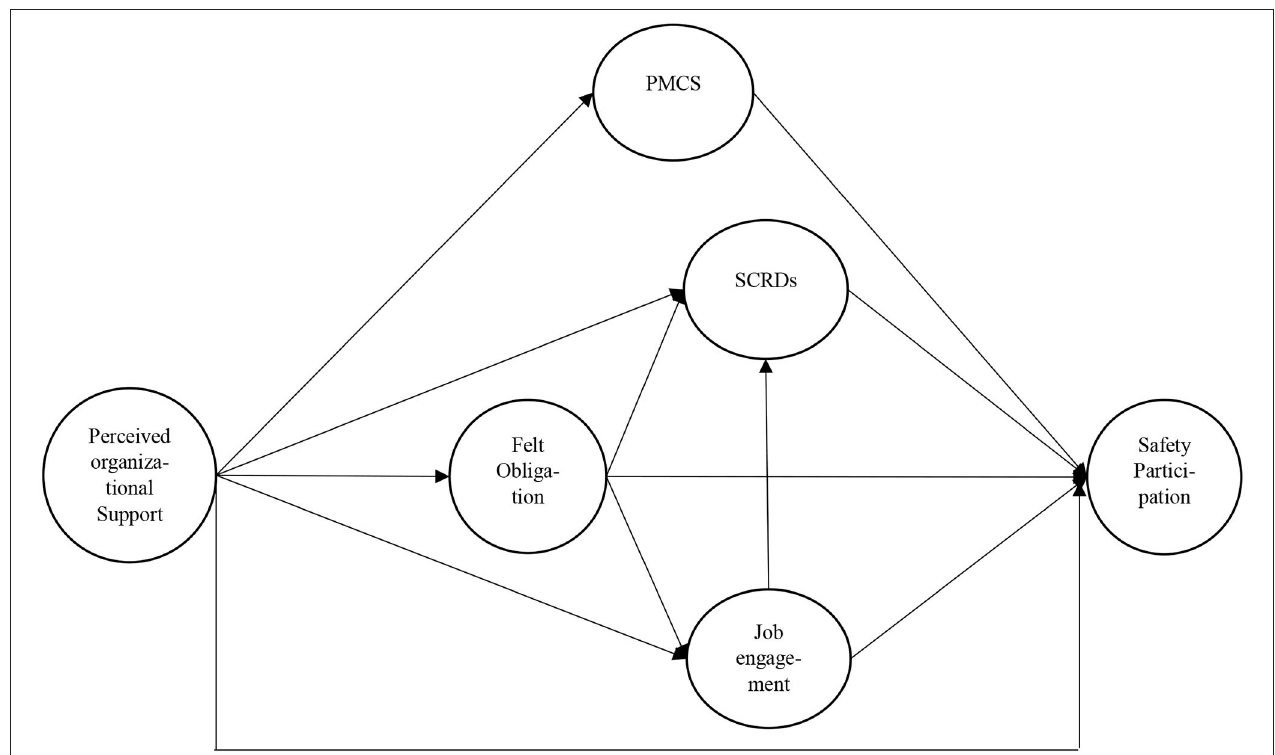
FIGURE 1 | Hypothetical model. PMCS, perceived management commitment to safety; FO, felt obligation; SCRDs, safety citizenship role definitions; Safety participation, reported participation in discretionary safety activities.